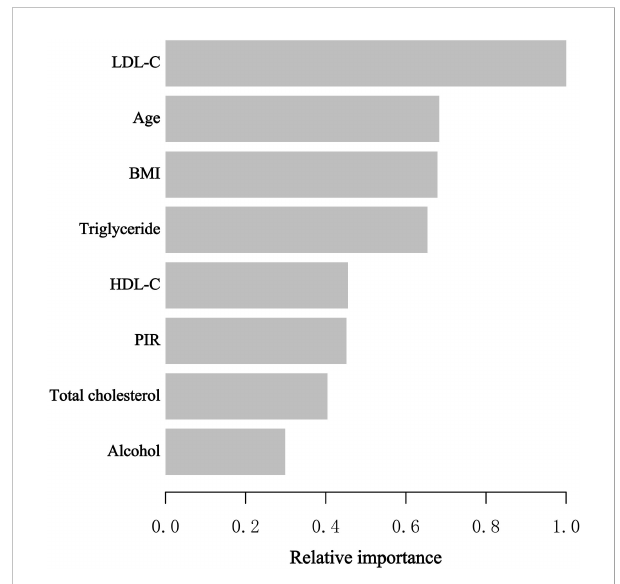
FIGURE 2 XGBoost algorithm model revealed the relative importance of selected variables on blood eosinophil counts as well as the variable importance score for each variable. The X-axis represented the importance score, the relative number of a variable used to distribute the data, and the Y-axis indicated the selected variables.